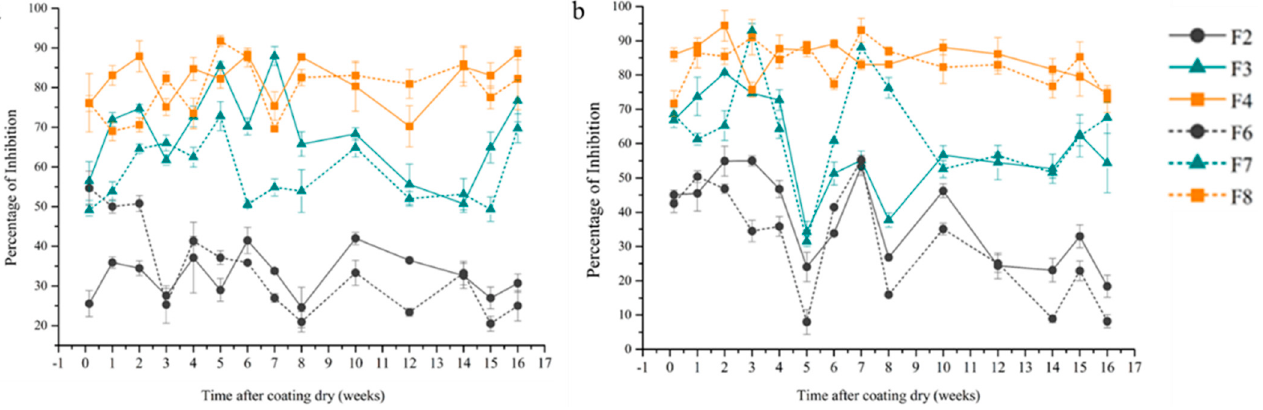
Figure 5. The kinetics of the inhibitory efficacy from 1 day to 16 weeks (4 months) of all coating formulas: ( a ) tested against E.coli O157:H7 and ( b ) tested against S. aureus ATCC25722.